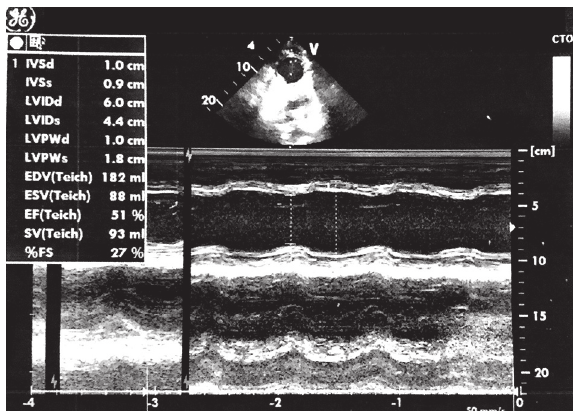
Figure 5: M-mode LV function before the patient was discharged from the PICU.